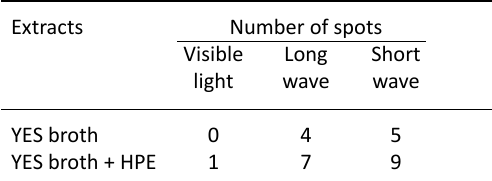
Table 4. Number of spots on TLC plate for different